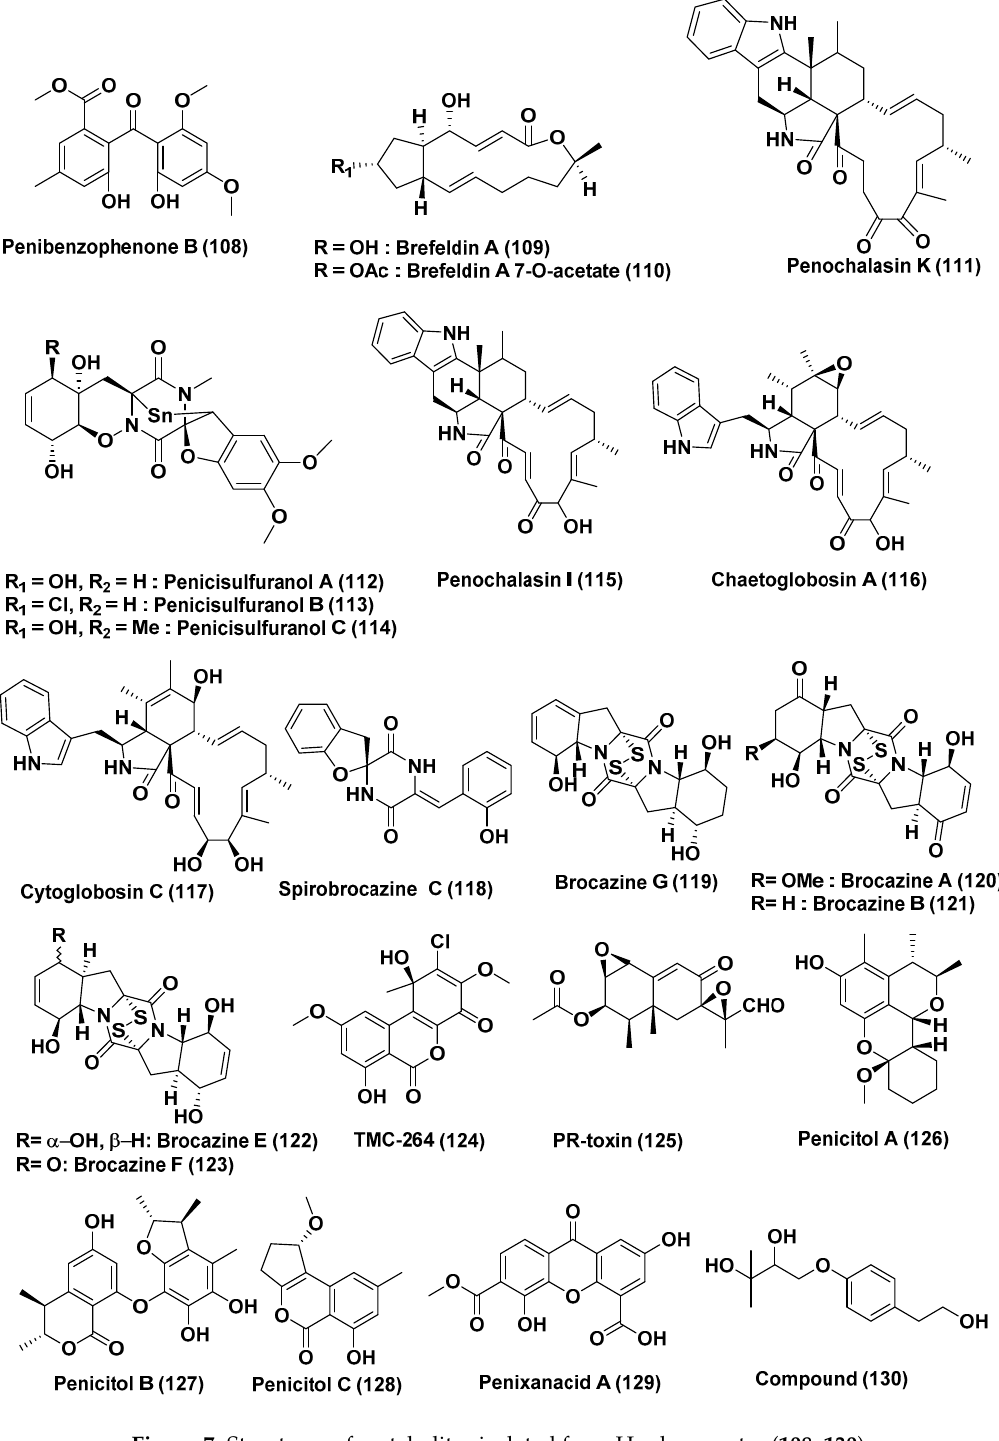
Figure 7. Structures of metabolites isolated from Hyphomycetes ( 108 – 130 ).